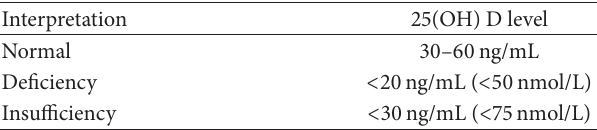
Table 1: Ranges for 25-hydroxy vitamin D